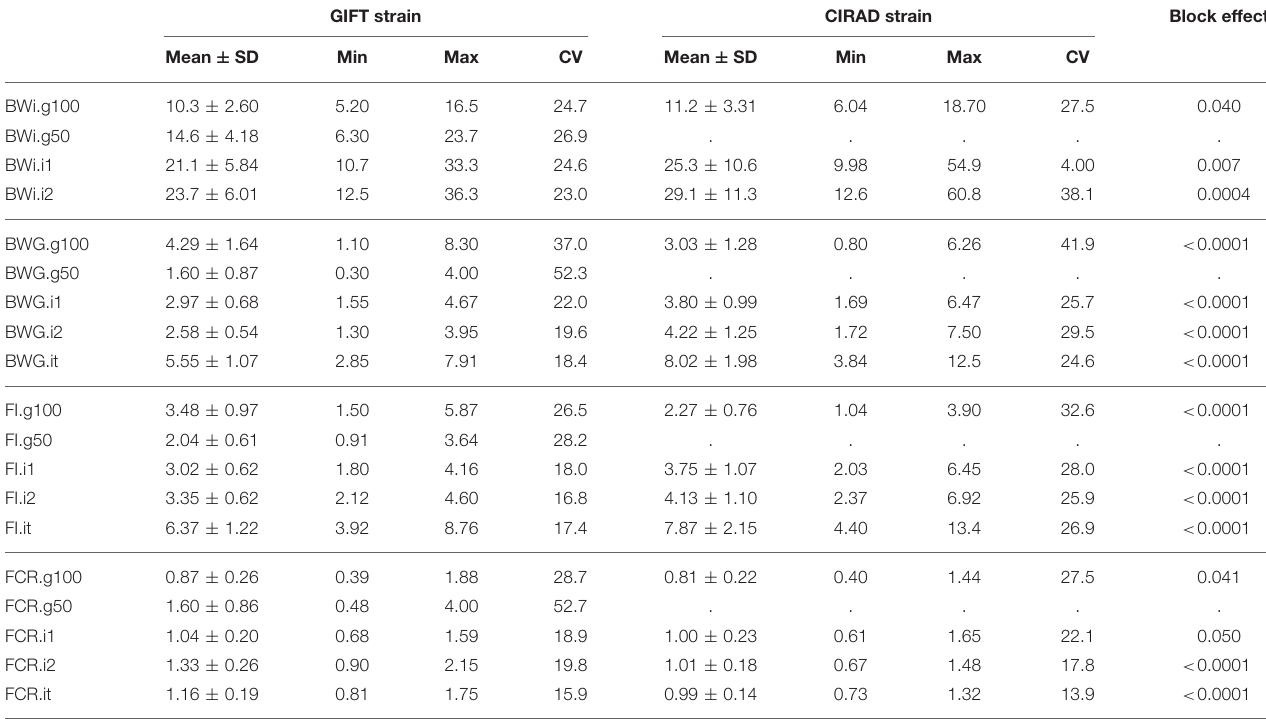
TABLE 1 | Basic statistics: mean ± standard deviation, minimum, maximum, and coefficient of variation (CV) of all the traits measured during the experiment for the GIFT and the Cirad strain, and the p -value of the block effect calculated using Wilcoxon tests. GIFT strain CIRAD strain Block effect Mean ± SD